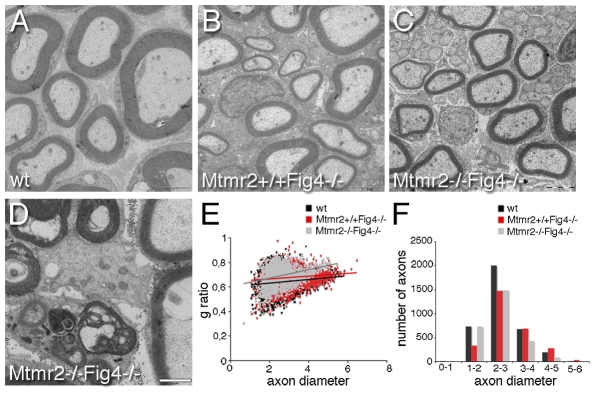
Hypomyelination in Mtmr2+/+Fig4−/− and Mtmr2−/−Fig4−/− sciatic nerves.(A–C and E) At P20, the g-ratio (the ratio between axonal diameter and the fiber diameter-axon plus myelin) in Mtmr2+/+Fig4−/− sciatic nerves (0.674±0.0014) is increased as compared to wild-type (0.6408±0.0013; P = 8.0253×10−63), suggesting the presence of hypomyelination, a reduction in myelin thickness. The g-ratio of Mtmr2−/−Fig4−/− (0.6885±0.0015) sciatic nerves is further increased as compared to Mtmr2+/+Fig4−/− nerves (P = 2.87033×10−12), suggesting that loss of Mtmr2 exacerbates hypomyelination of Fig4-null. (D) Electron microscopy of a Mtmr2−/−Fig4−/− nerve, showing myelin debris and axonal degeneration. (F) The axon diameter distribution is normal in both Mtmr2−/−Fig4−/− and Mtmr2+/+Fig4−/−as compared to wild-type, thus excluding loss of axons. In (E, F) axon diameter is in µm scale. From 4 to 5 animals per genotype were analyzed. n = 3450 fibers for wild-type; n = 2650 fibers for Mtmr2+/+Fig4−/−, and n = 2746 fibers for Mtmr2−/−Fig4−/−, t-test analysis. Bar is 2 µm in (A–C) and 1 µm in (D).